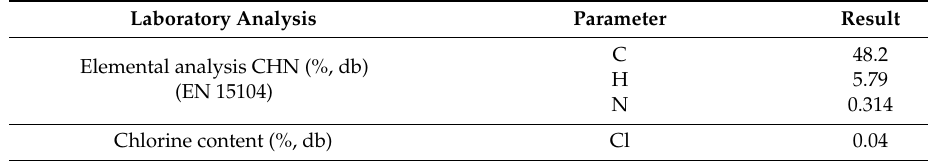
Table 1. Results obtained in the laboratory